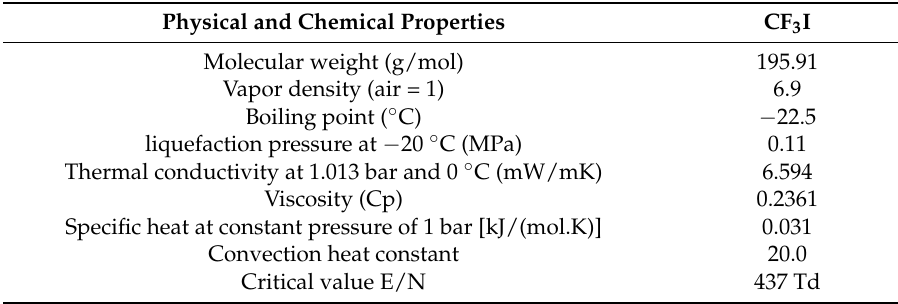
Table 7. Physical and chemical properties of CF 3 I [29,30].